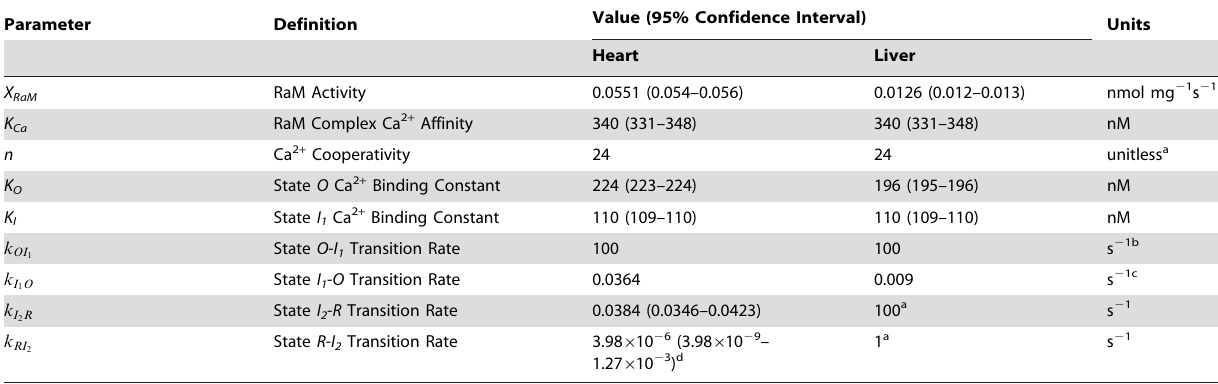
Table 1. 4-State RaM Model